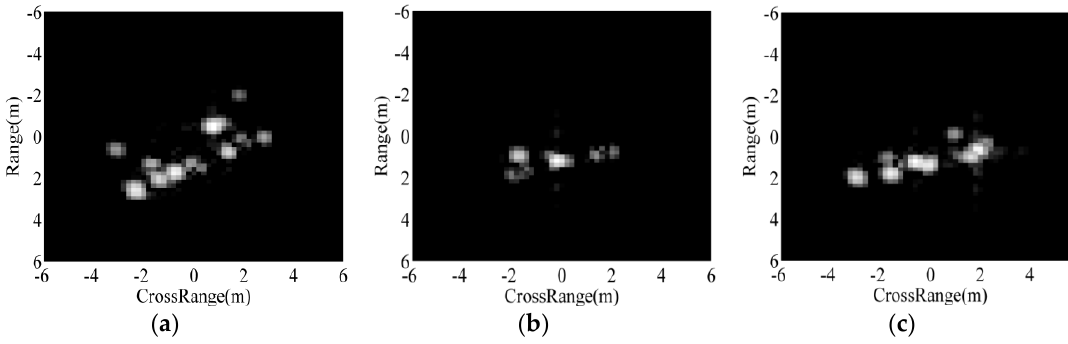
Figure 6. The reconstructed template images based on the matching results from different targets: ( a ) BMP2; ( b ) T72; ( c ) BTR70.